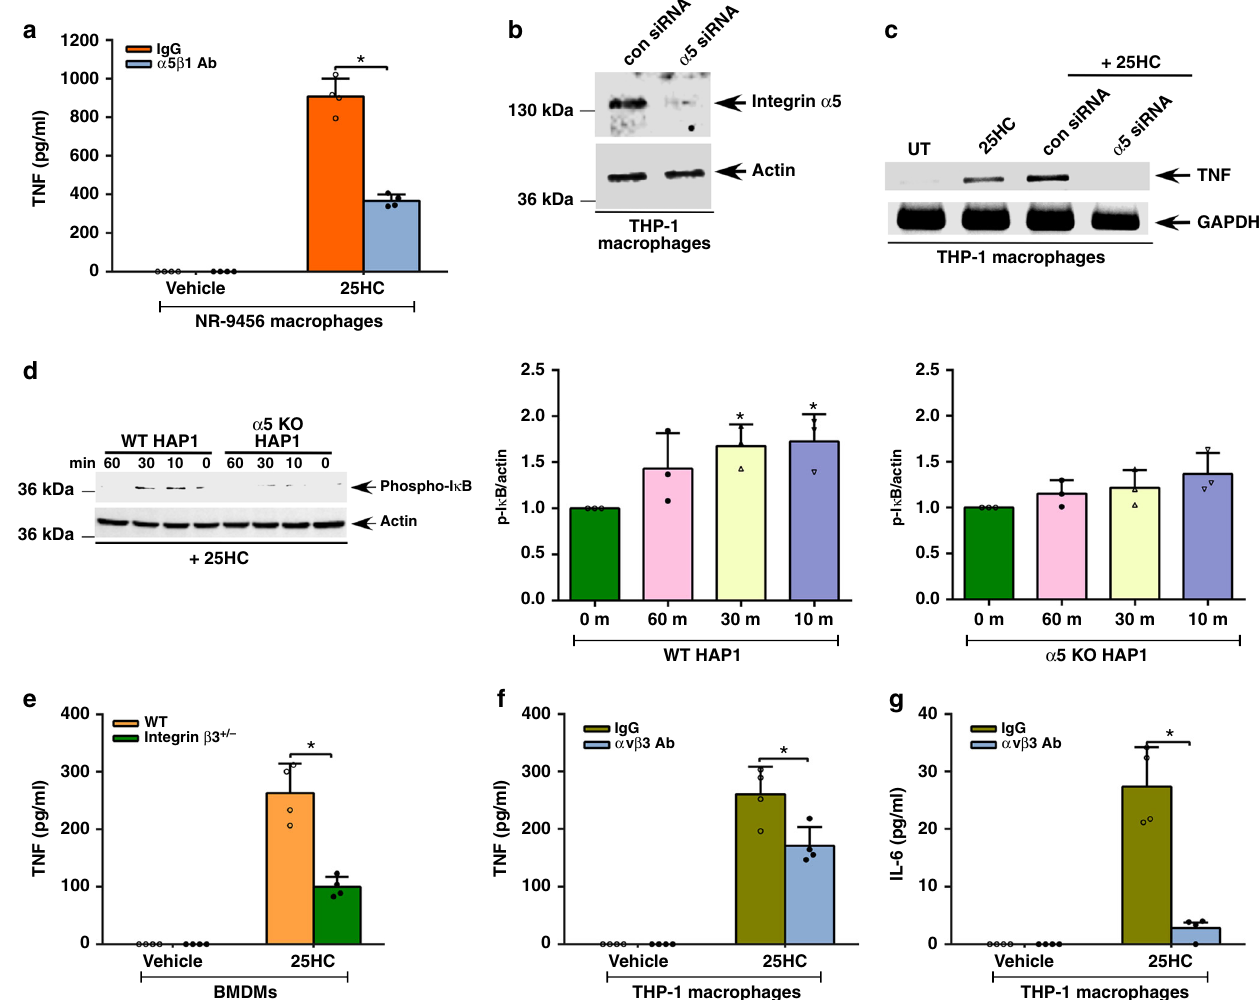
Fig. 5 α 5 β 1 and α v β 3 integrins regulate 25HC-mediated proin fl ammatory response. a , c – g α 5 β 1 and α v β 3 integrin-de fi cient cells were treated with 50 µ M 25HC for 8 h to evaluate NF κ B activation and proin fl ammatory response. a TNF secretion from 25HC-treated NR-9456 macrophages in the presence of either control IgG or α 5 β 1 integrin blocking antibody (Ab). b Western blot analyses of α 5 integrin protein expression in THP-1 cells transfected with either control siRNA (con siRNA) or α 5 integrin-speci fi c siRNA ( α 5 siRNA). c RT-PCR analyses of TNF expression in 25HC-treated THP-1 cells transfected with either control siRNA (con siRNA) or α 5 integrin-speci fi c siRNA ( α 5 siRNA). d Western blot and densitometric analyses of phospho-I κ B status in 25HC- treated wild-type (WT) and α 5 integrin knockout (KO) HAP1 cells. e TNF secretion from 25HC-treated WT and β 3 integrin-de fi cient ( β 3 + / − cells) BMDMs. f , g TNF ( f ) and IL-6 ( g ) secretion from 25HC-treated THP-1 macrophages in the presence of either control IgG or α v β 3 integrin blocking